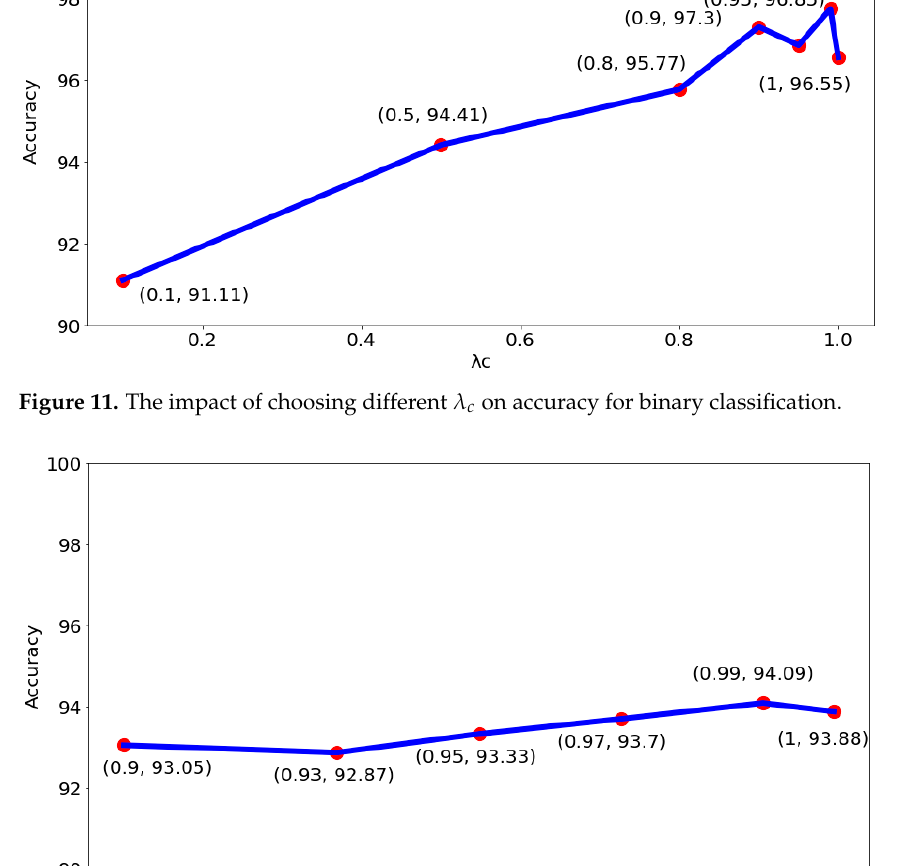
Figure 12. The impact of choosing different 𝜆 (cid:3030) on accuracy for multi-class classification.